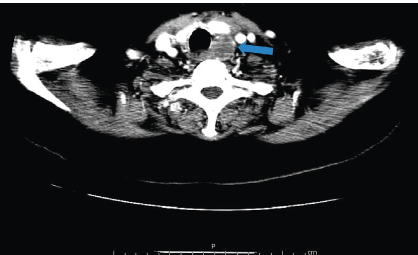
Figure 1: Neck CT showing a left parapharygeal/paralaryngeal nonenhancing mass (blue arrow) with 2.3cm of maximum diameter.